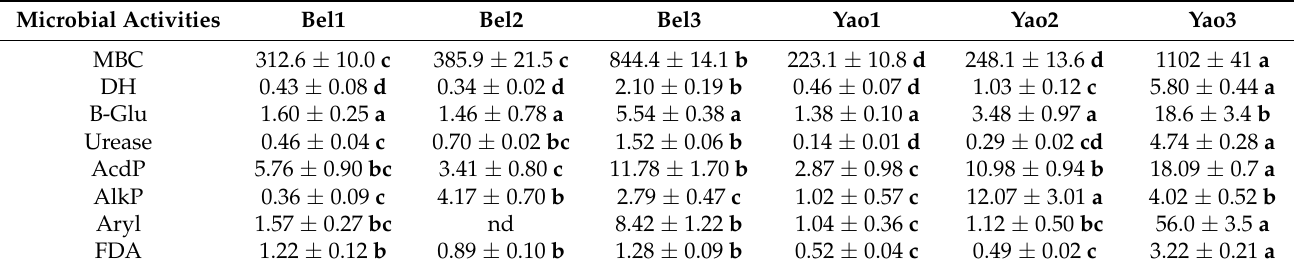
Table 2. Soil Microbial Biomass and soil enzymes activities involved in soil biogeochemical cycles in the six rehabilitated sites ( n = 5, mean ± SD). MBC: Soil microbial biomass carbon in mg · kg − 1 , DH: Dehydrogenase activity in µ g TPF (red- colored formazan) g − 1 soil h − 1 , B-Glu, AcdP, AlkP and Aryl: β -glucosidase, Acid phosphatase, Alkaline phosphatase and